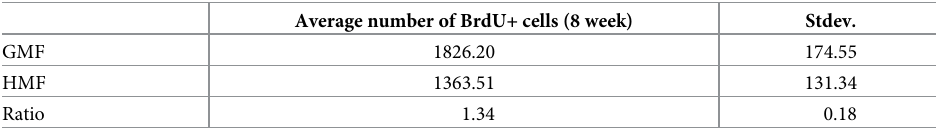
Table 1. The numbers of BrdU+ cells in mice after a 8 week exposure to HMF and GMF. Average number of BrdU+ cells (8